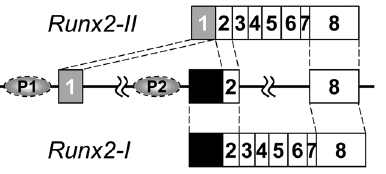
Figure 1. Runx2 gene construct and splicing patterns. Runx2 transcription is induced by distal and proximal promoters (P1 and P2, respectively). Although the first exon of Runx2-II contains a 197-bp mini- intron, the two parts of the exon are often shown as a single exon (exon 1), as we have done here (gray box). Exon 2, the first exon for Runx2-I consists of a Runx2-I -specific sequence (black box; includes a coding sequence that is translated into five amino acids unique to Runx2-I, MRIPV) and a common sequence (white box; corresponds to the second